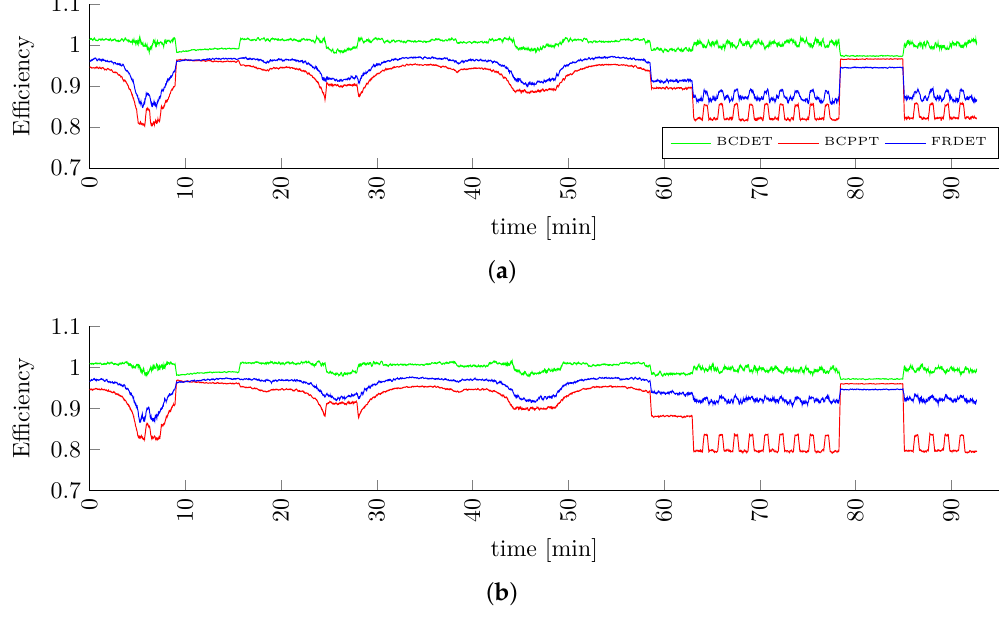
Figure 15. System efficiency for initial OCV of: ( a ) 4.0V; ( b )